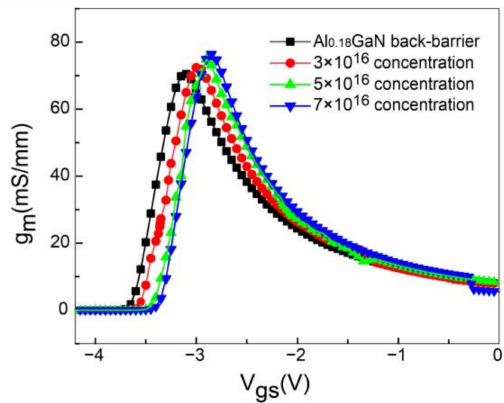
Figure 5. The transconductance (g m ) of the structure with and without the local p-doped region.